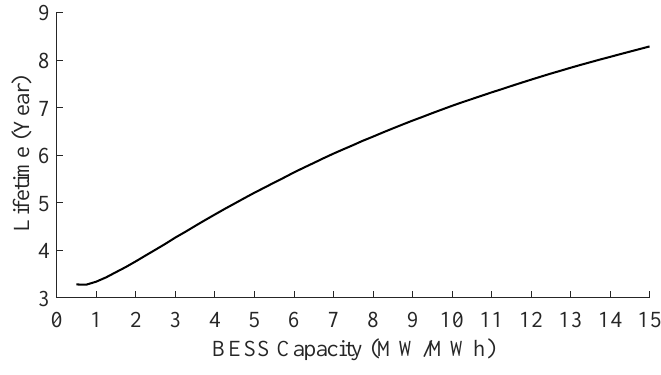
Figure 19. BESS lifetime in